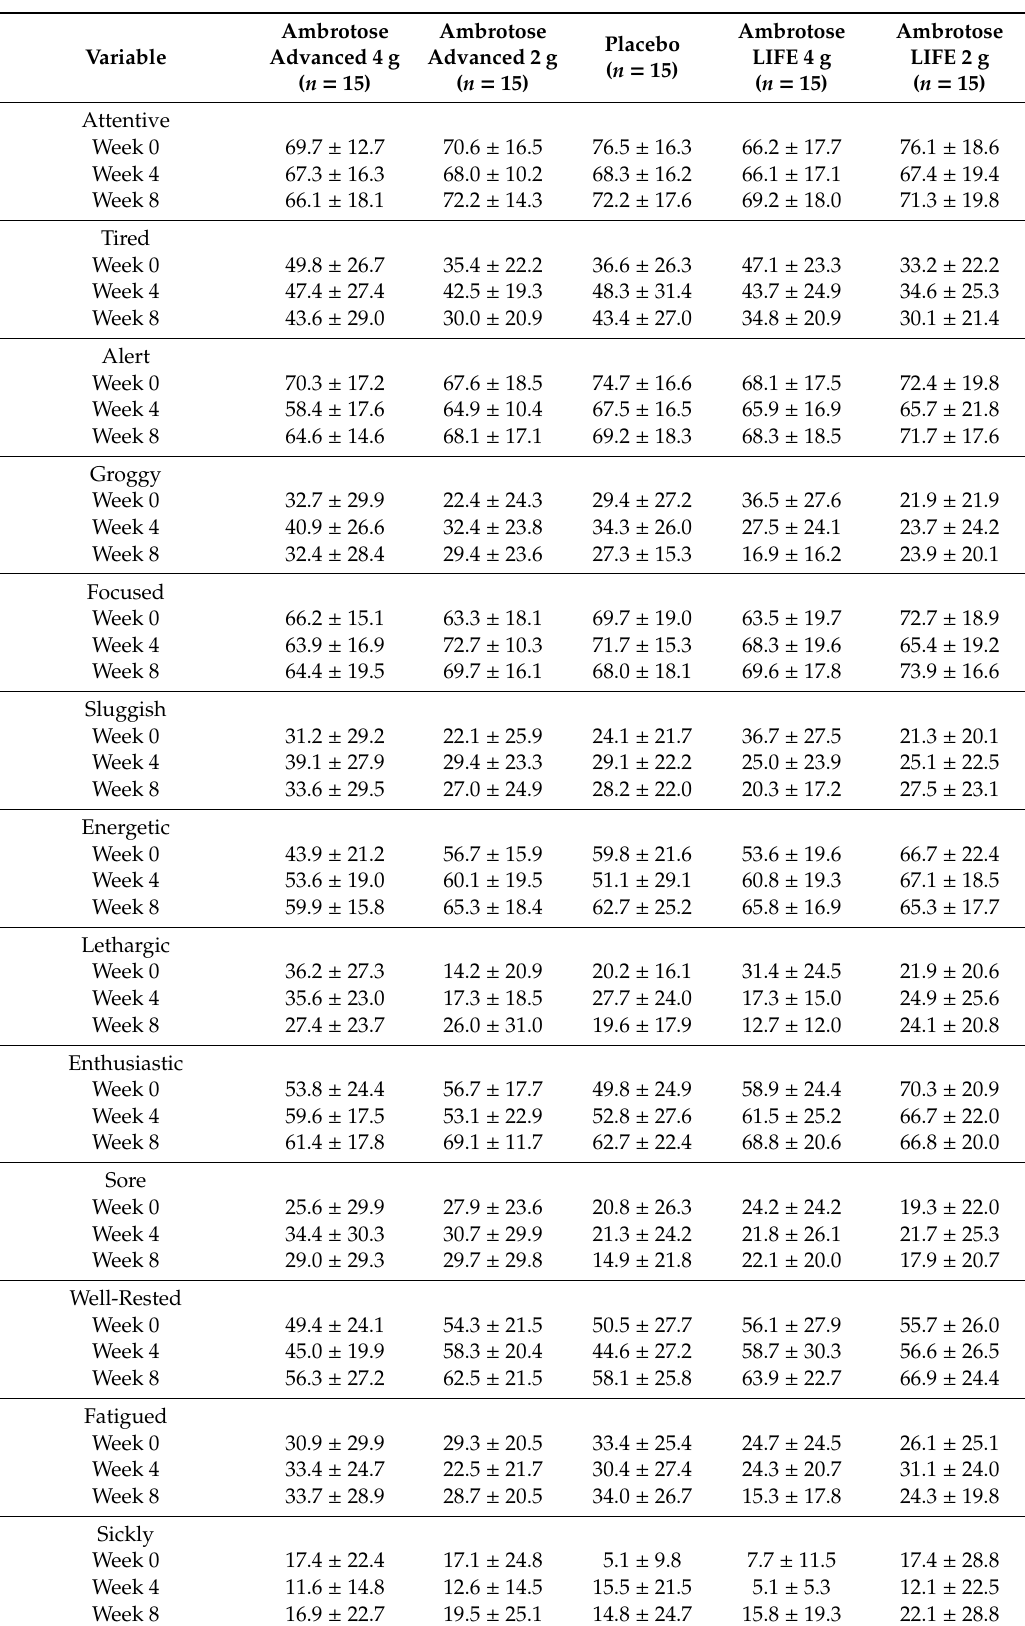
Table 4. Subjective feelings of 75 healthy men and